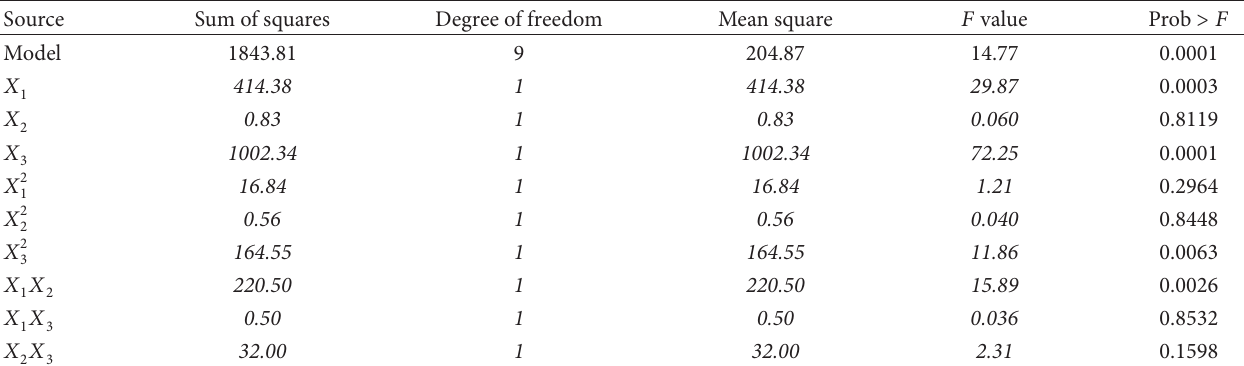
T 2: ANOVA results for MB removal by BPAC.